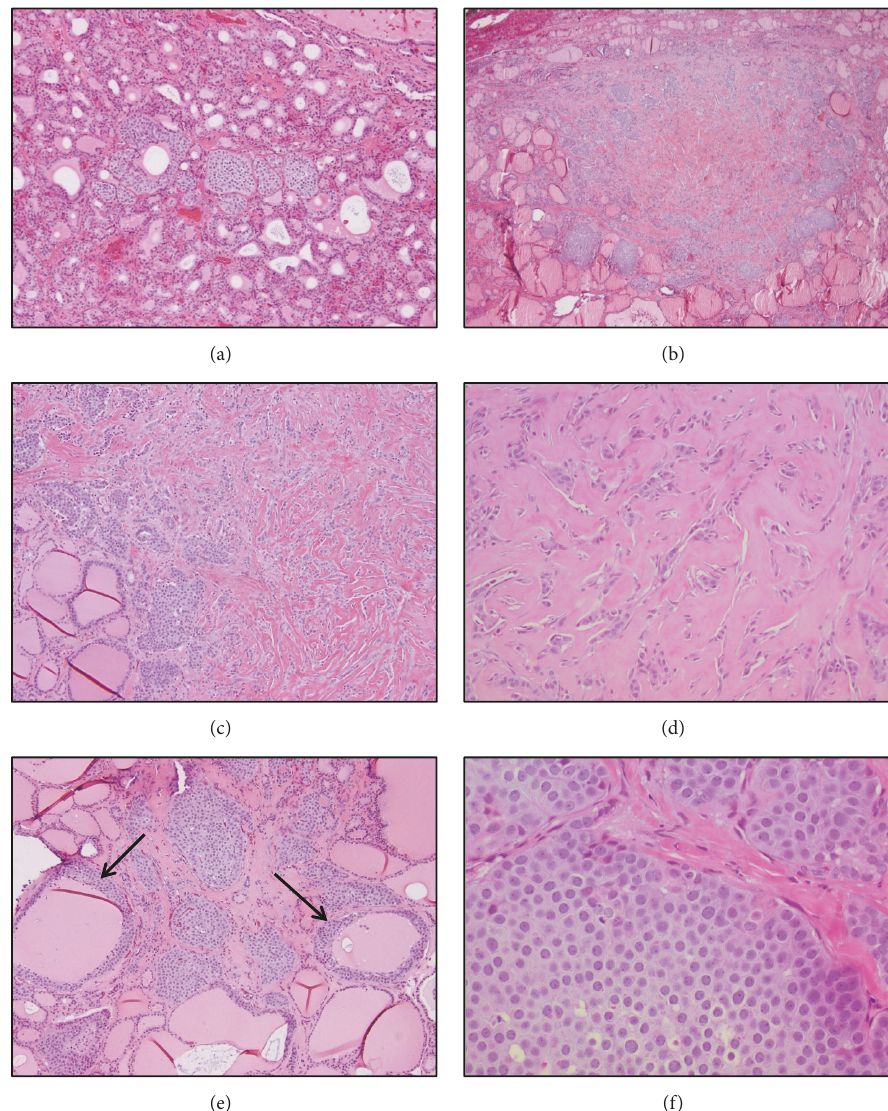
Figure 1: One of the smallest metastatic deposits consists of a few irregularly shaped nests of tumor cells spanning only one millimeter ((a), x100).Oneof thelarger metastaticdeposits consists of afairly well-circumscribedproliferation of tumorcells, whichare arranged peripherally in nests and centrally as cords within a sclerotic stroma ((b), x40). The densely sclerotic stroma in this focus of metastatic breast carcinoma resembles the amyloid-type stroma seen in medullary thyroid carcinoma ((c), x100), and the embedded cords and small nests of tumor cells display pronounced retraction artifact ((d), x200). Some metastatic deposits show prominent peripheral rimming of the thyroid follicles by tumor cells, in a pattern reminiscent of C cell hyperplasia ((e), x100). The tumor cells have round nuclei with fine chromatin and prominent nucleoli, ample eosinophilic cytoplasm, and distinct cell borders ((f), x400).